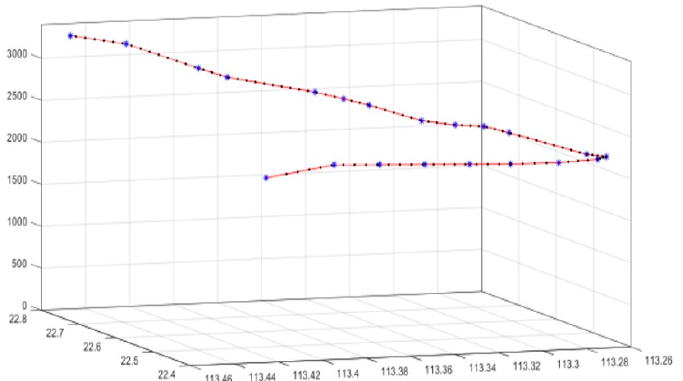
Figure 1. Piecewise linear interpolation of the discrete aircraft positions downloaded from FlightAware. Blue asterisks are the original flight tracking points with position information, and black points are the image locations interpolated from original flight tracking points.